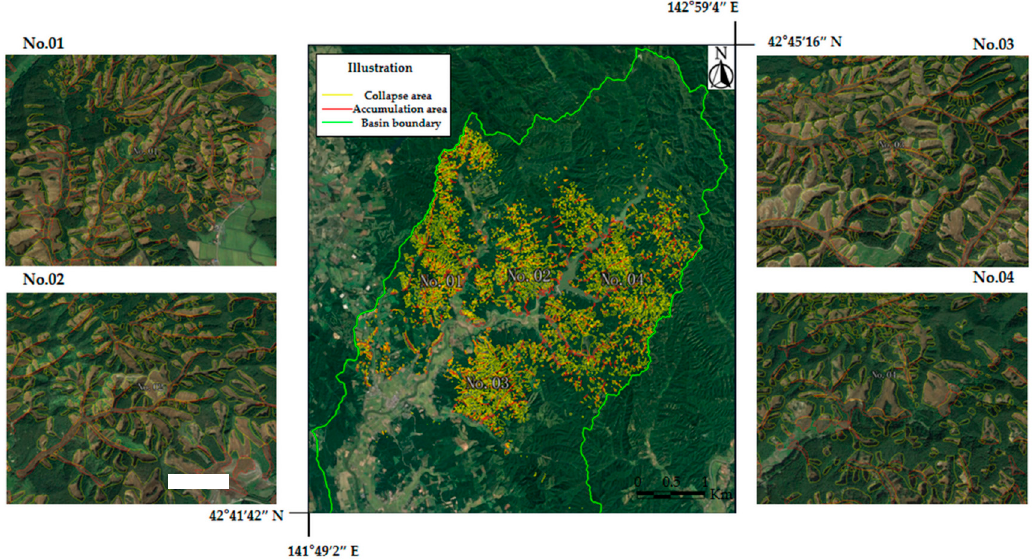
Figure 3. Distribution map of slope collapse/sediment accumulation in the Atsuma River basin caused by the 2018 Hokkaido Eastern Iburi Earthquake [31].